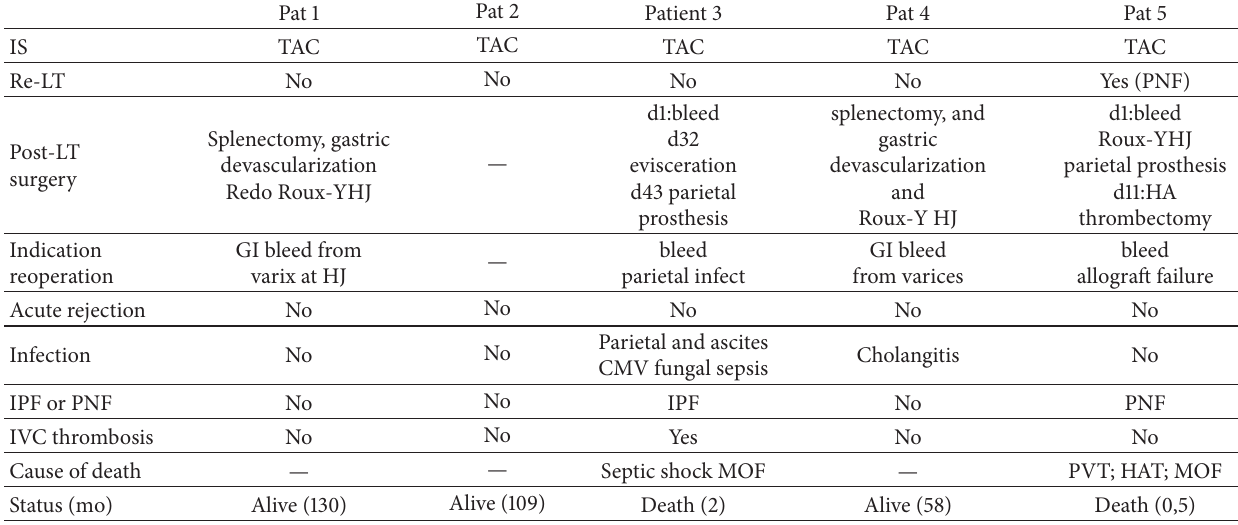
Table 3: Outcome after LT for diffuse splanchnic venous